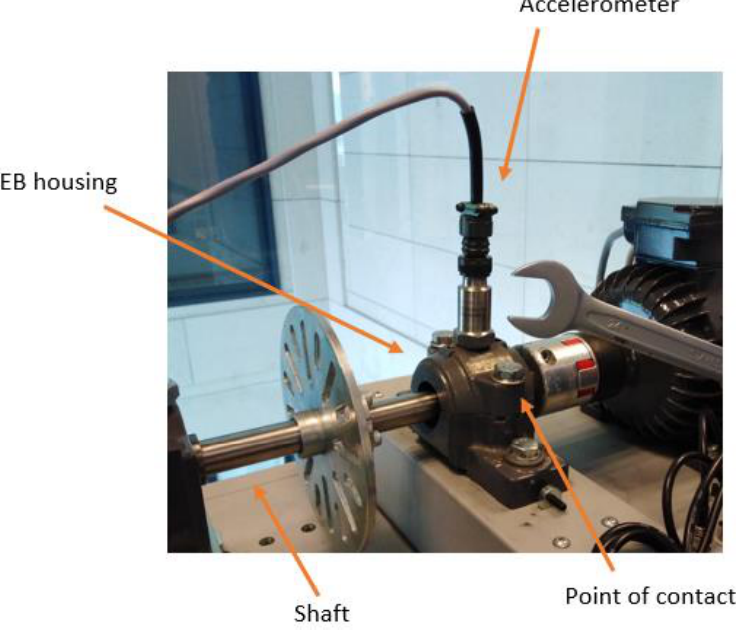
Figure 2. REB housing.